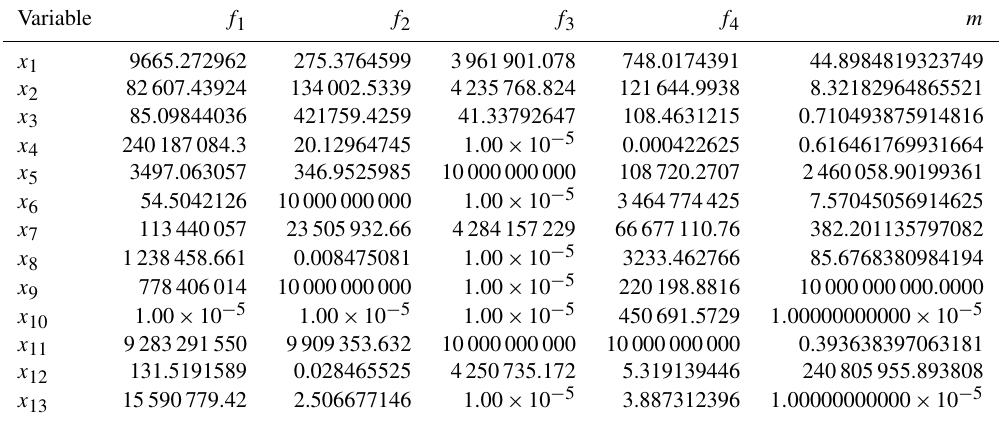
Table 4. Correlation coefficients of the Kriging model.